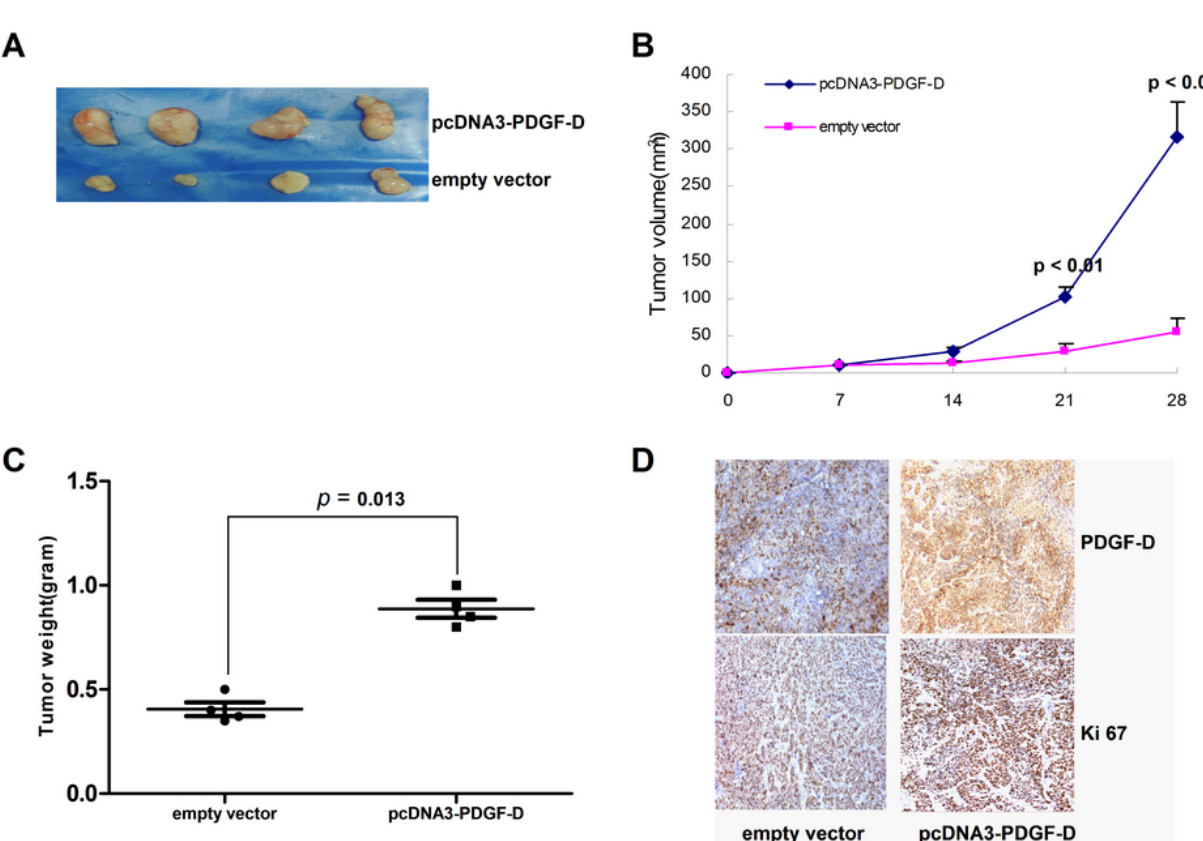
Figure 5. In nude mice, PDGF-D promoted the growth of ECC-1 xenografts. ( A ) The general picture of tumors formed by ECC-1 cells; ( B ) Compared to the negative control, over-expression of PDGF-D significantly promoted the growth of ECC-1 xenografts ( N = 4 in each group, p < 0.01 on the 21th day and p < 0.001 on the 28th day); ( C ) The tumor weights were also increased by PDGF-D notably ( p = 0.013); ( D ) In the tumor tissues with high PDGF-D, the Ki 67 protein was significantly